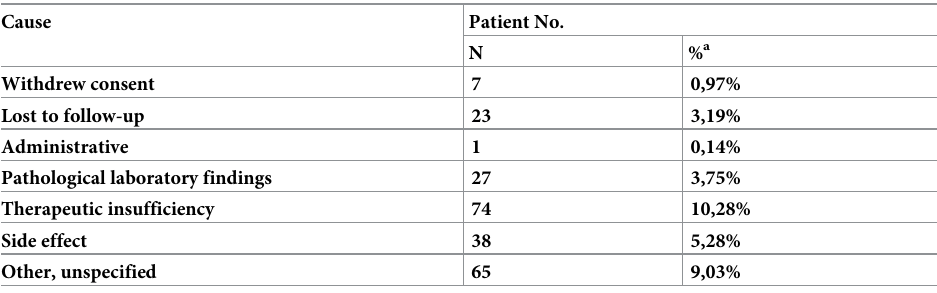
Table 5. Reasons for early